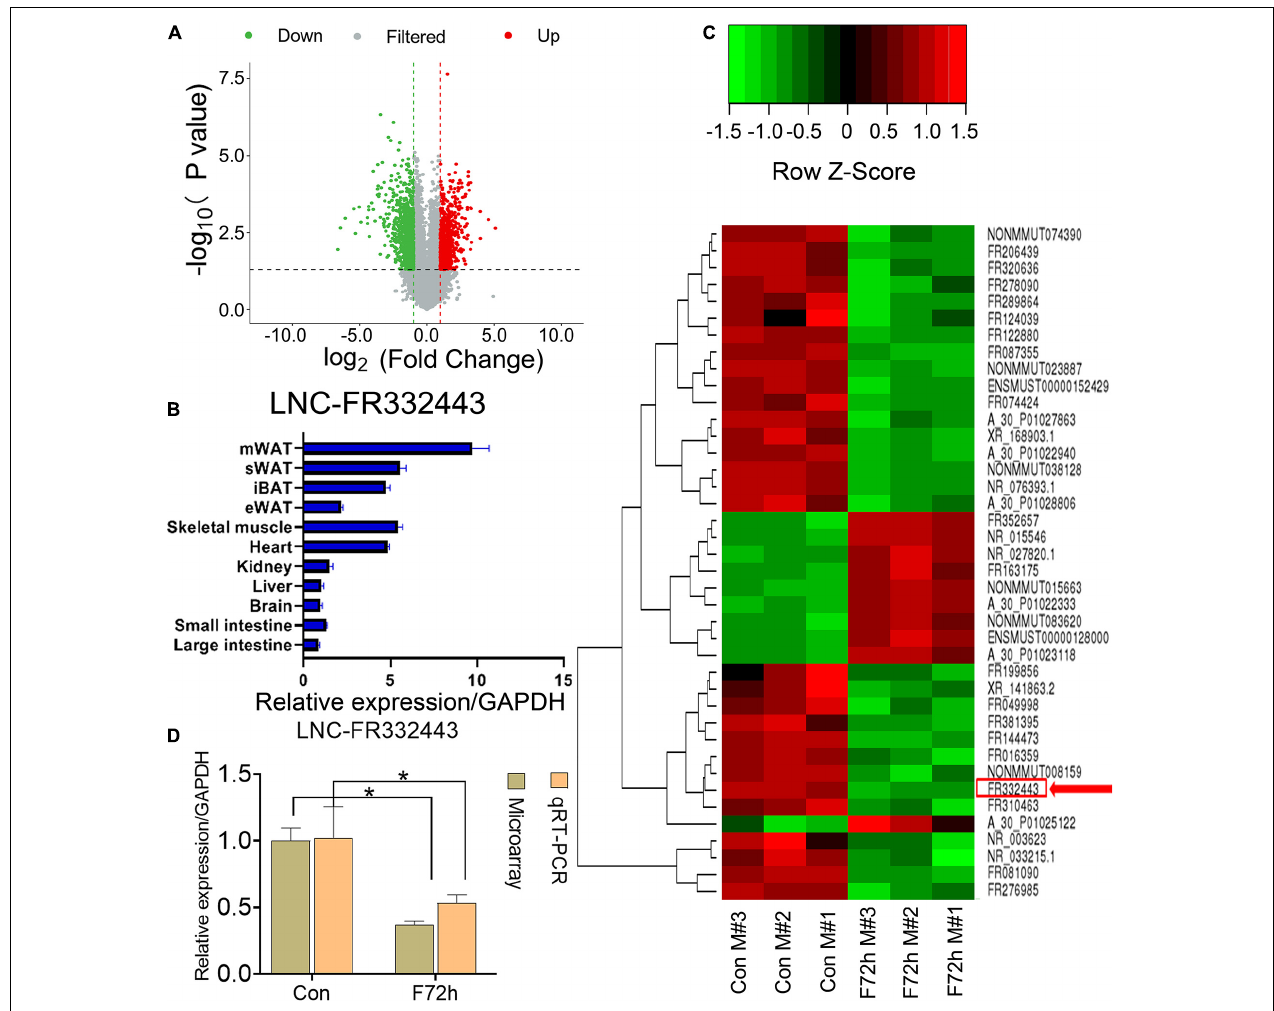
FIGURE 1 | Identification of differentially expressed lncRNAs in F72h mouse mWAT compared with control mouse mWAT. (A) A volcano plot illustrating the expression of the differentially regulated lncRNAs from microarray analysis between the control and F72h male mouse mWAT. (B) Expression profile of Lnc-FR332443 across 11 mouse tissues examined by qPCR. (C) Cluster heat map showing differentially expressed lncRNAs in mWAT between the F72h mice and control mice. The red arrow shows Lnc-FR332443 . N = 3. (D) Comparison of microarray data and qRT-PCR data for Lnc-FR332443 in mWAT between the F72h mice and the control mice. All data are expressed as the mean ± SEM, N = 3, * P <